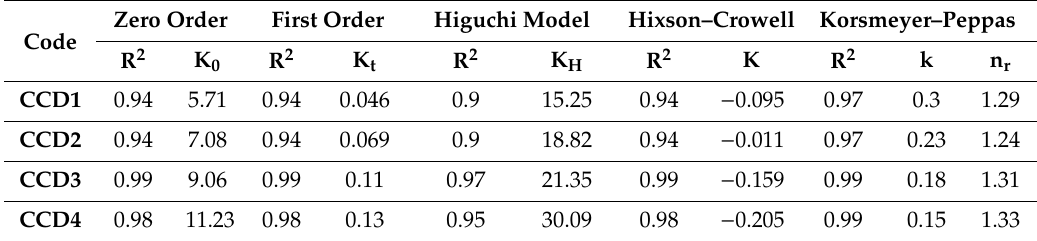
Table 4. The kinetic data obtained in the first stage of 0–4 h.